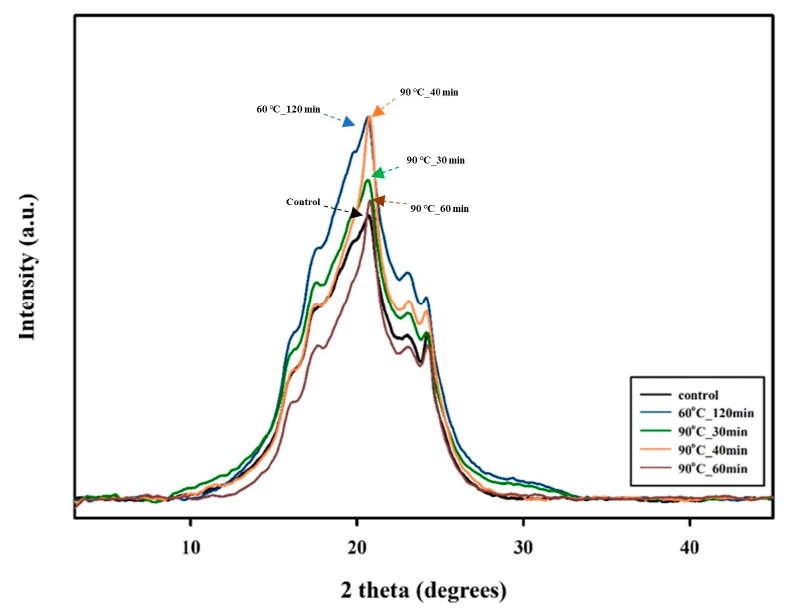
Figure 8. XRD data for PBSeT after SSP processing at 90 °C. Samples that underwent SSP processing at 60 °C for 120 min are added for comparison. The intensity of the peak increases as SSP time increases.